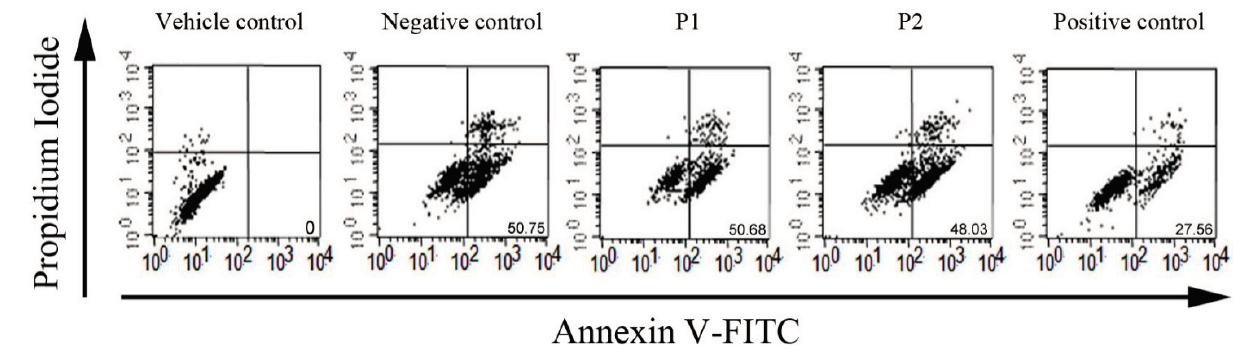
Figure A1. Effect of WBH peptides on H retreated with 50 µM P1 and P2 for 12 h before exposure to 300 µM H was assayed by annexin V-FITC and PI staining and analyzed by flow cytometry with fluorescence-activated cell